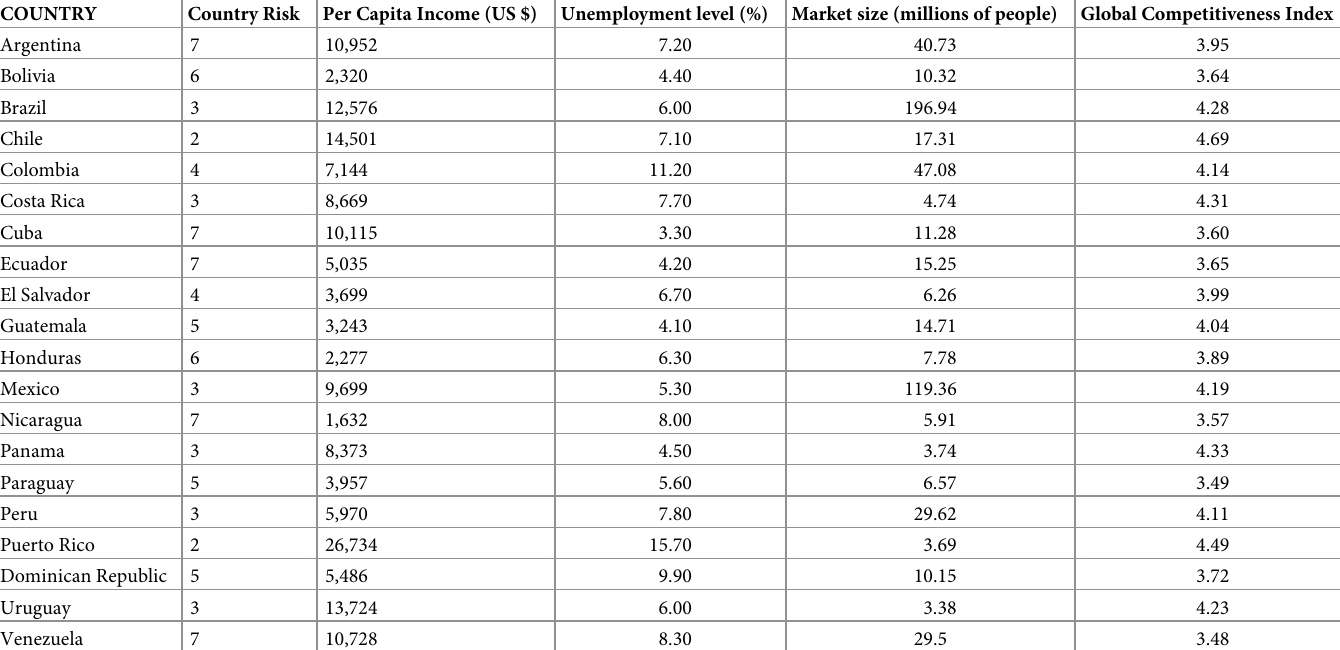
Table 4. Explanatory variables in the Latin American countries.